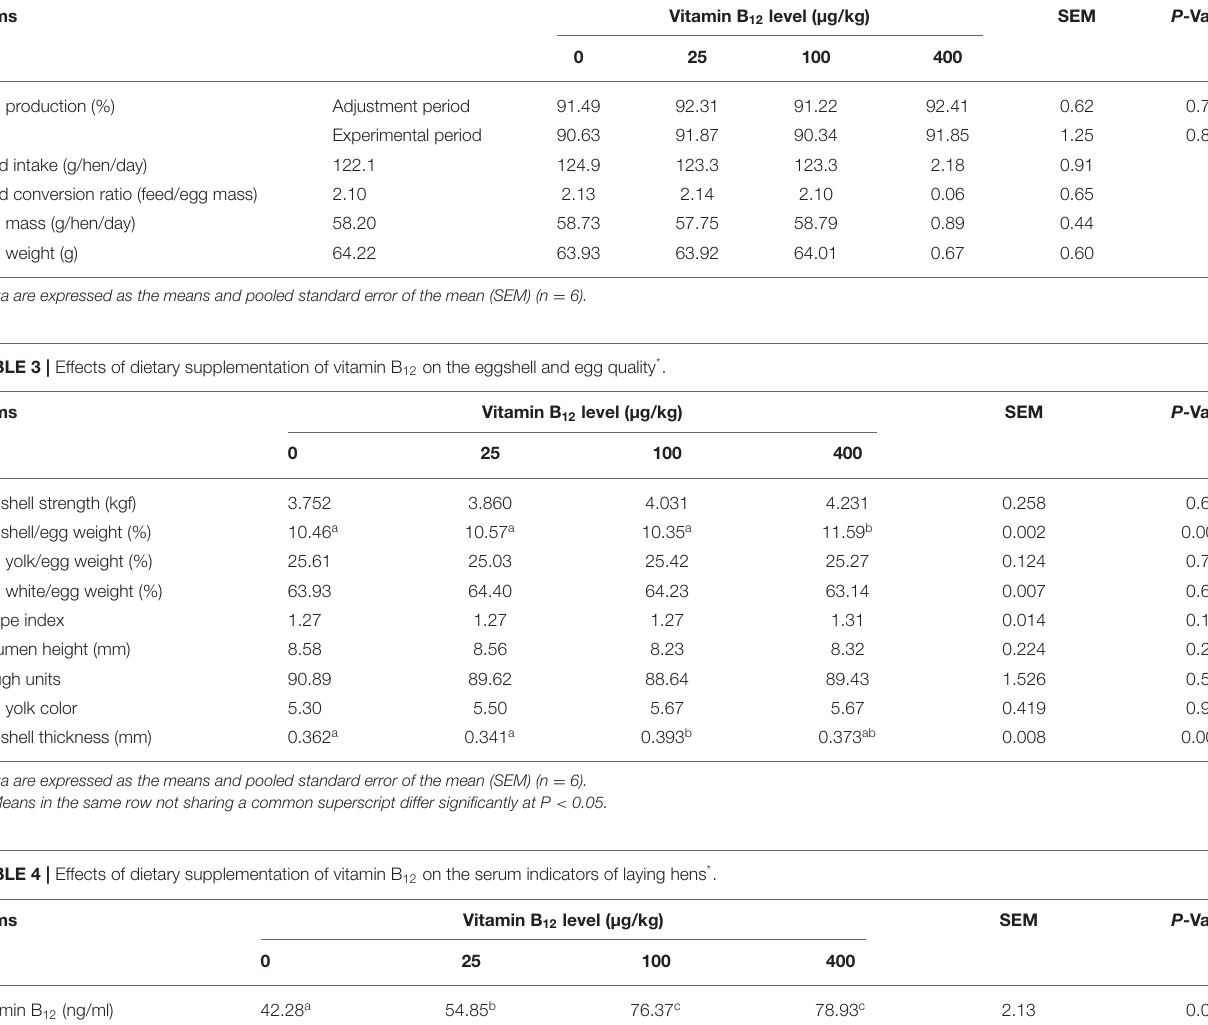
TABLE 2 | Effects of dietary supplementation of vitamin B 12 on the production performance of laying hens * . Items